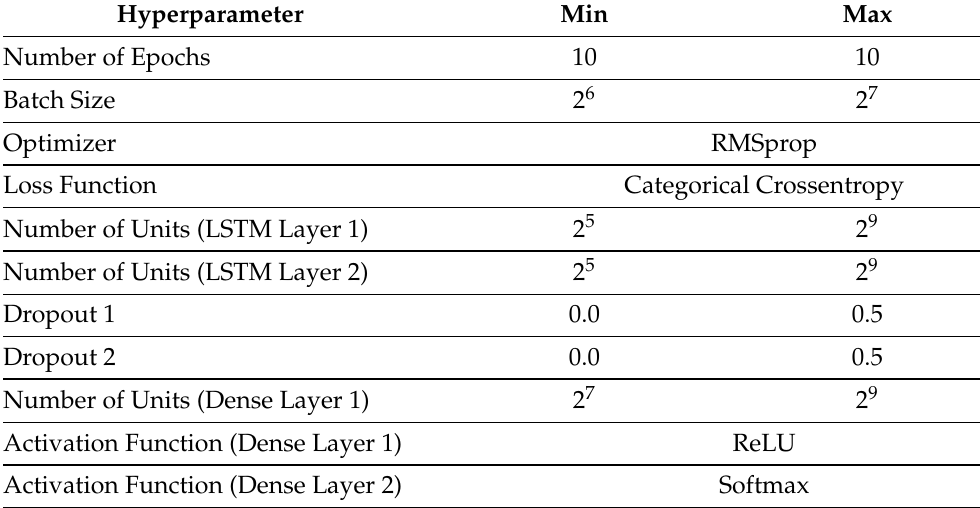
Table 9. Evaluated hyperparameters of the RNN